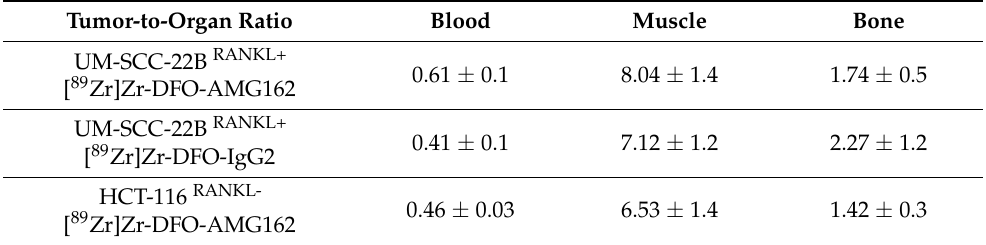
Table 2. Tumor-to-organ ratio 5 days post injection in mice bearing UM-SCC-22B ([ 89 Zr]Zr-DFO- AMG162 ( n = 4) and [ 89 Zr]Zr-DFO-IgG2 ( n = 5) and HCT-116 ([ 89 Zr]Zr-DFO-AMG162 ( n = 5) xenografts. Data is shown below as mean ± the standard